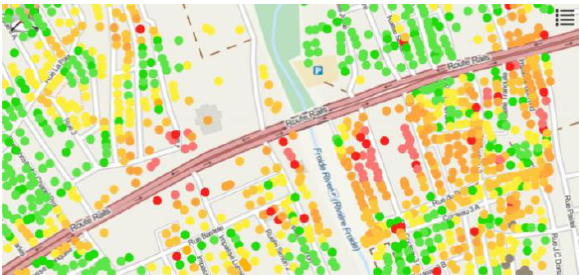
Figure 8. Visualized interpolation of the mobile solution (fig. from Laun, 2015)